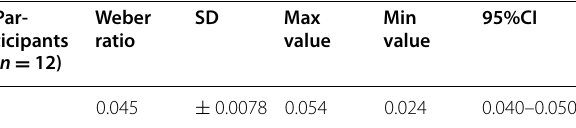
Table 2 Weber ratio in 60% of the weight-bearing